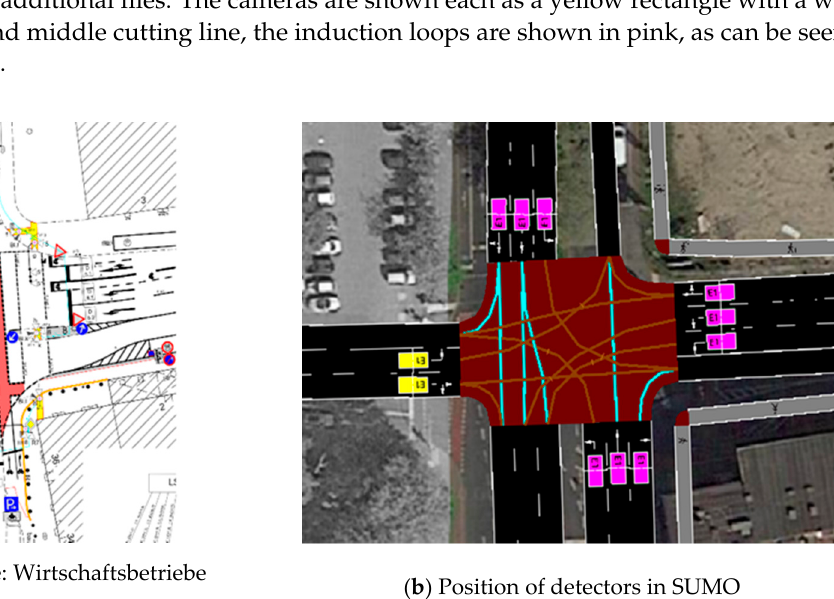
Figure 4. Position of detectors of an intersection. ( a ) on map, ( b ) in SUMO.